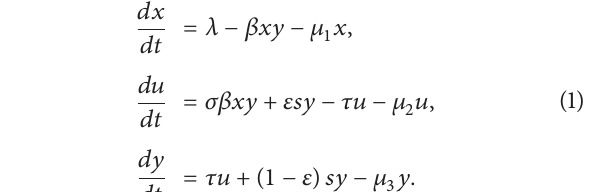
coefficient among 𝐶𝐷4 + T cells [25]. The newly infected cells experience an irreparable destruction by the strong adaptive immune responses. As a result, a small fraction 𝜎𝛽𝑥𝑦 , 𝜎 ∈ (0, 1) , survives after the immune attack and becomes the resting infected cells [14, 22]. Every day, a small proportion 𝜏 of resting infected cells express Tax with 𝜏 ∈ (0.3 % , 3 % ) [26]. The mitotic transmission of HTLV-1 involving selective clonal expansion of these Tax-expressing 𝐶𝐷4 + T cells occurs at a rate 𝑠 . The newly infected cells from mitosis to the resting infected cells compartment are 𝜀𝑠𝑦 , 𝜀 ∈ (0, 1) , with (1−𝜀)𝑠𝑦 staying in the Tax-expressing infected 𝐶𝐷4 + T-cell compartment. The transfers among those three compartments are shown in Figure